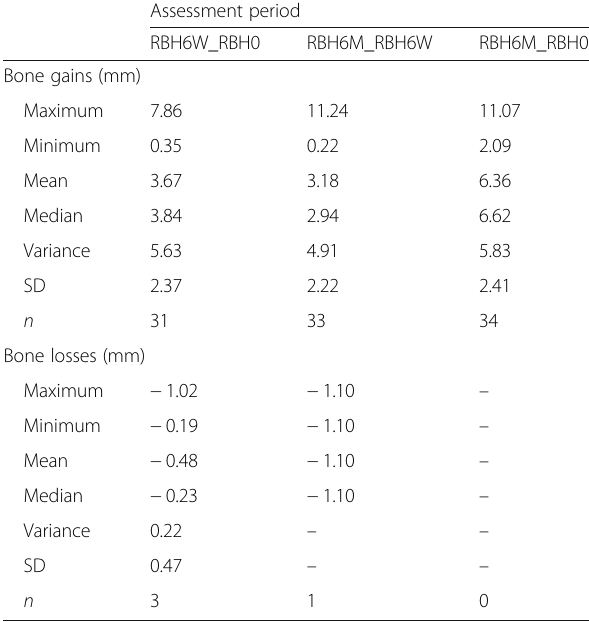
Table 7 Comparison of mean RID change according to